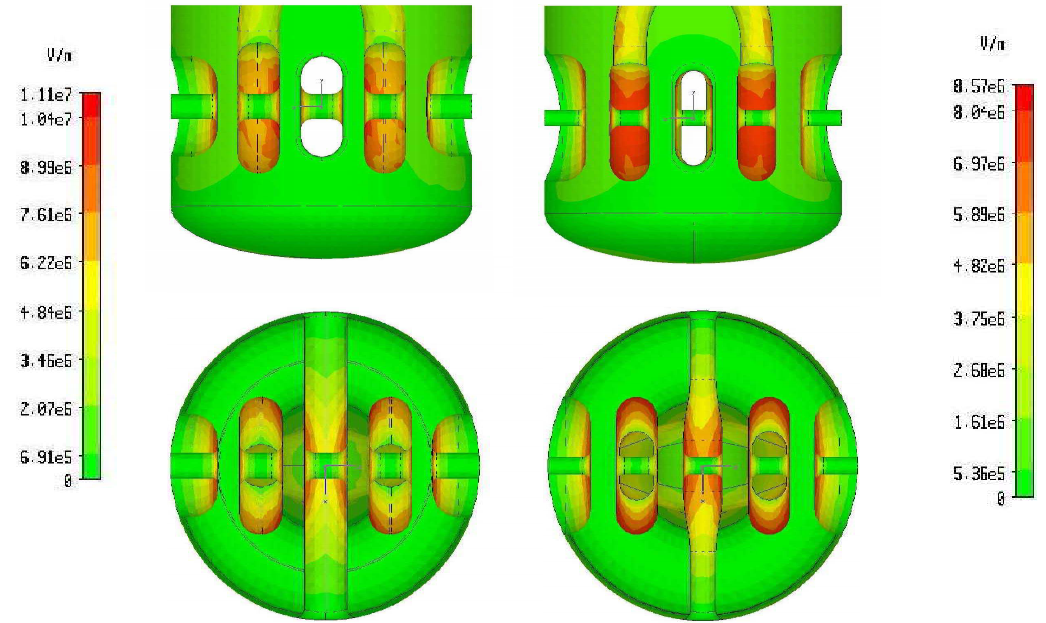
FIG. 4. (Color) Surface electric field distribution in (cid:8) x; z (cid:9) and (cid:8) y; z (cid:9) planes. The preliminary design (on the left) and optimized design (on the